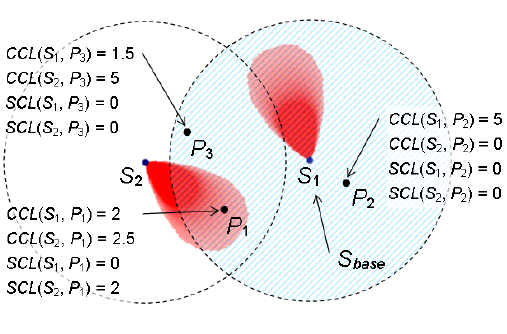
Figure 8. An example of the topology control